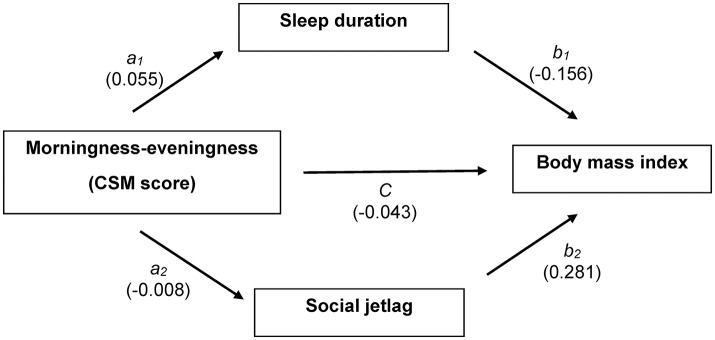
Causal association diagram between CSM score and body mass index with multiple mediation models; CSM score is an independent variable, sleep duration and social jetlag are mediators, and body mass index is an outcome. Coefficient for each path is shown.